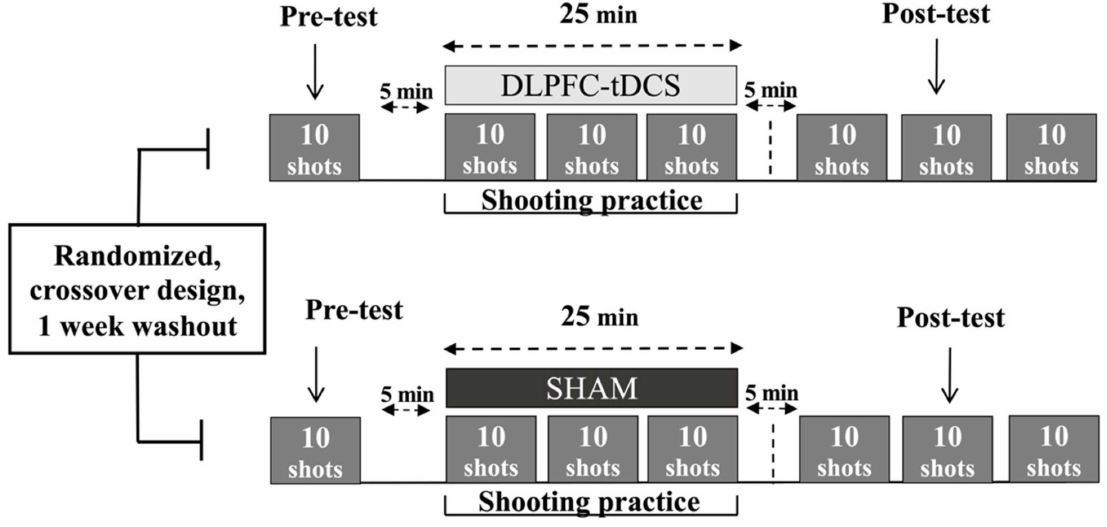
Figure 1. Experimental design. A schematic representation of the experimental protocol for a single practice session for each of the two conditions (DLPFC-tDCS, SHAM) is depicted for illustrative purposes, although an identical protocol was performed in each condition for 3 consecutive days. A week washout period between the two 3-Day series of practice sessions was implemented after which the participants crossed over to the opposite